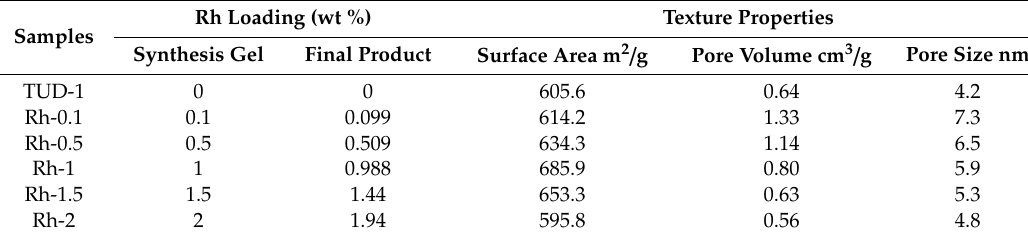
Figure 1. ( A ) Comparison between the Rh% loading in the synthesis gel and in the obtained final solid product. ( B ) N 2 sorption isotherms for the prepared Rh-TUD-1 samples. Table 1. The Rh% in the prepared Rh-TUD-1 samples, as obtained from elemental analysis, compared with that in the synthesis gel. Moreover, the texture properties of the prepared Rh-TUD-1, as obtained from the N 2 sorption measurement.